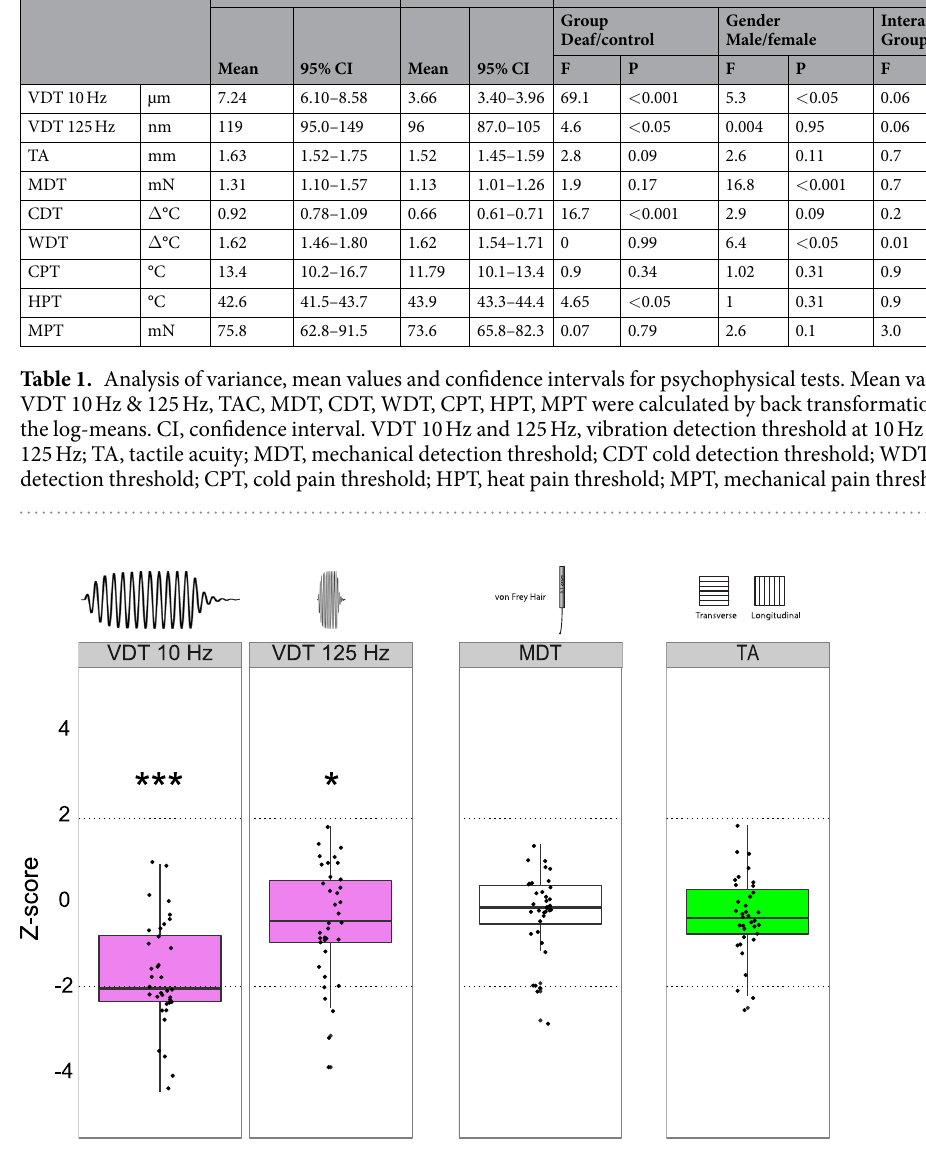
Figure 2. Vibration detection threshold (VDT) at 10 Hz and 125 Hz, mechanical detection threshold (MDT), and tactile acuity (TA) in the congenitally deaf cohort (n = 36). Each point represents the threshold for a single subject. All values are normalized for gender on a Z-scale. Dotted lines designate the upper (z = 1.96) and lower (z = − 1.96) boundaries of the 95% confidence interval of the normal standard distribution of healthy subjects (n = 111). Z-scores > 0 indicate increased sensitivity. Z-scores < 0 indicate decreased sensitivity to sinusoidal vibrations. * P < 0.05, ** P < 0.01, *** P < 0.001, unpaired T-test. Box plots characteristics: center lines show the medians; box limits indicate the 25th and 75th percentiles; whiskers extend 1.5 times the interquartile range from the 25th and 75th